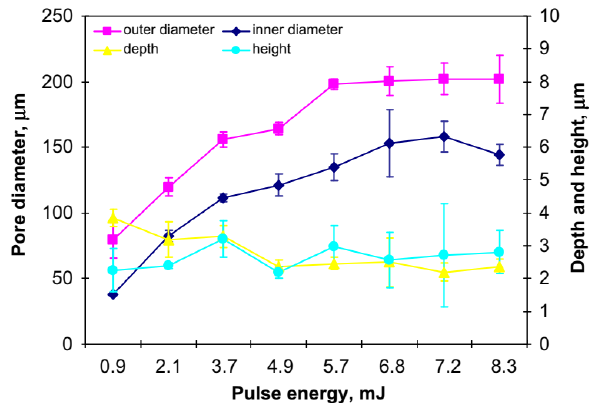
Figure 1. The effect of the pulse energy on the dimple diameter, depth and height. Reproduced with permission from [37].